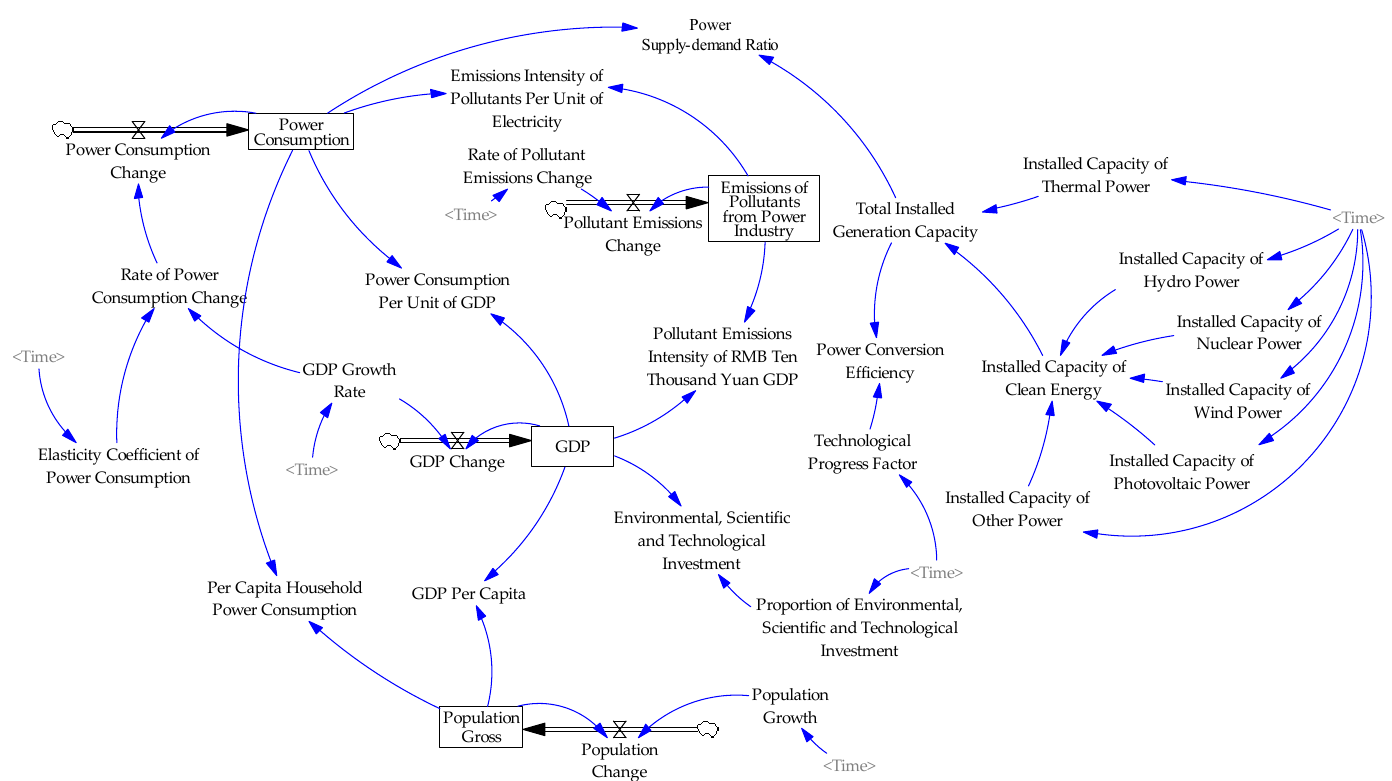
Figure 7. Flow-stock diagram of the system dynamics (SD) model of the power supply and demand system.